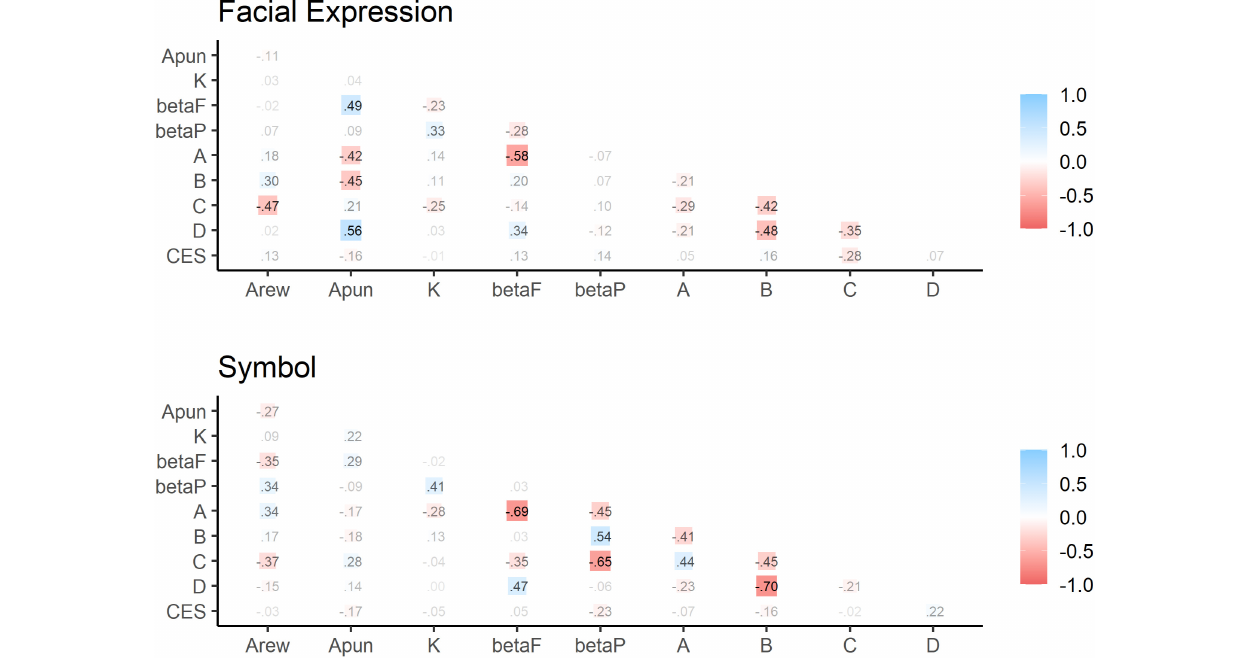
FIGURE 3 | Correlation matrix for Iowa Gambling Task performances, feedback condition, and individual differences. Note: A = the frequency of Deck A choice, B = the frequency of Deck B choice, C = the frequency of Deck C choice, and D = the frequency of Deck D choice. CES = the average scores of all items for the Center for Epidemiological Studies Depression